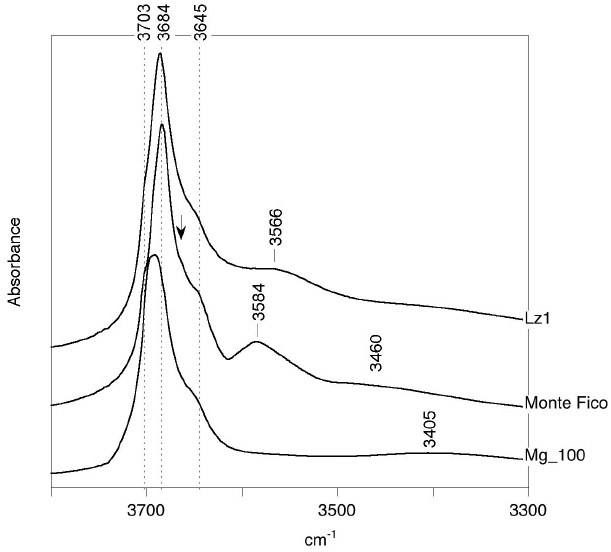
Figure 4. Experimental FTIR spectra of lizardite samples: New Caledonian Lz1 sample from Fritsch et al. (2021), Monte Fico sam- ple from Balan et al. (2002) and laboratory-grown Mg_100 sample from Baron and Petit (2016). The arrow points to the shoulder at ∼ 3664cm − 1 in the spectrum of the Monte Fico